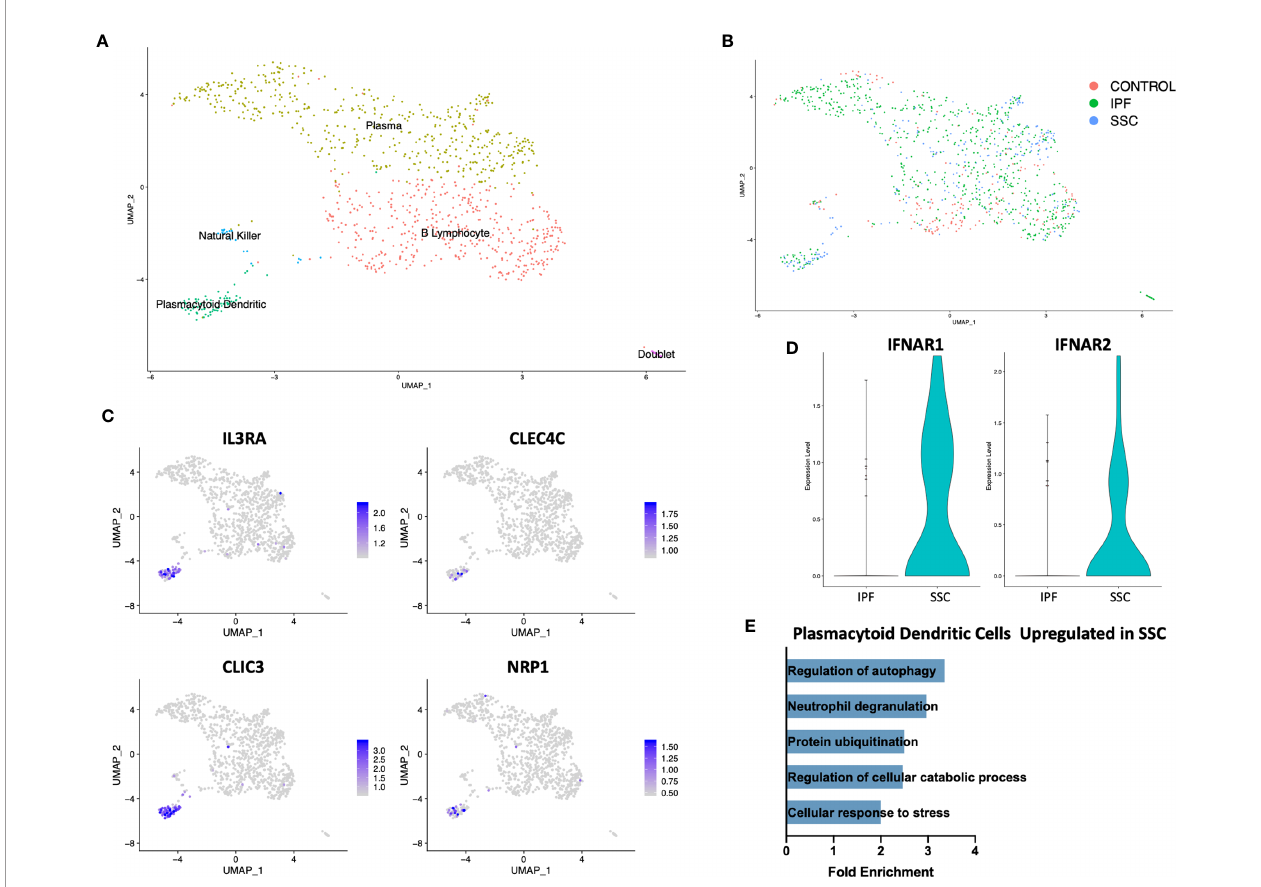
FIGURE 4 | ScRNA-seq analysis of IPF, SSc-ILD, and control plasmacytoid dendritic cell populations. (A) UMAP plot of the reclustered original B lymphocyte and plasma cell cluster, identi fi ed by cell type. (B) UMAP plot of the reclustered original B lymphocyte and plasma cell cluster, identi fi ed by disease status. (C) Expression of IL3RA, CLEC4C, CLIC3 , and NRP1 , identifying pDCs. (D) Expression of IFNAR1 and IFNAR2 in IPF versus SSc-ILD pDCs. (E) Pathways upregulated in SSc-ILD pDCs compared to IPF pDCs. scRNA-seq, single-cell RNA-sequencing; IPF, idiopathic pulmonary fi brosis; SSc-ILD, systemic sclerosis-associated interstitial lung disease; UMAP, uniform manifold approximation and projection; pDCs, plasmacytoid dendritic